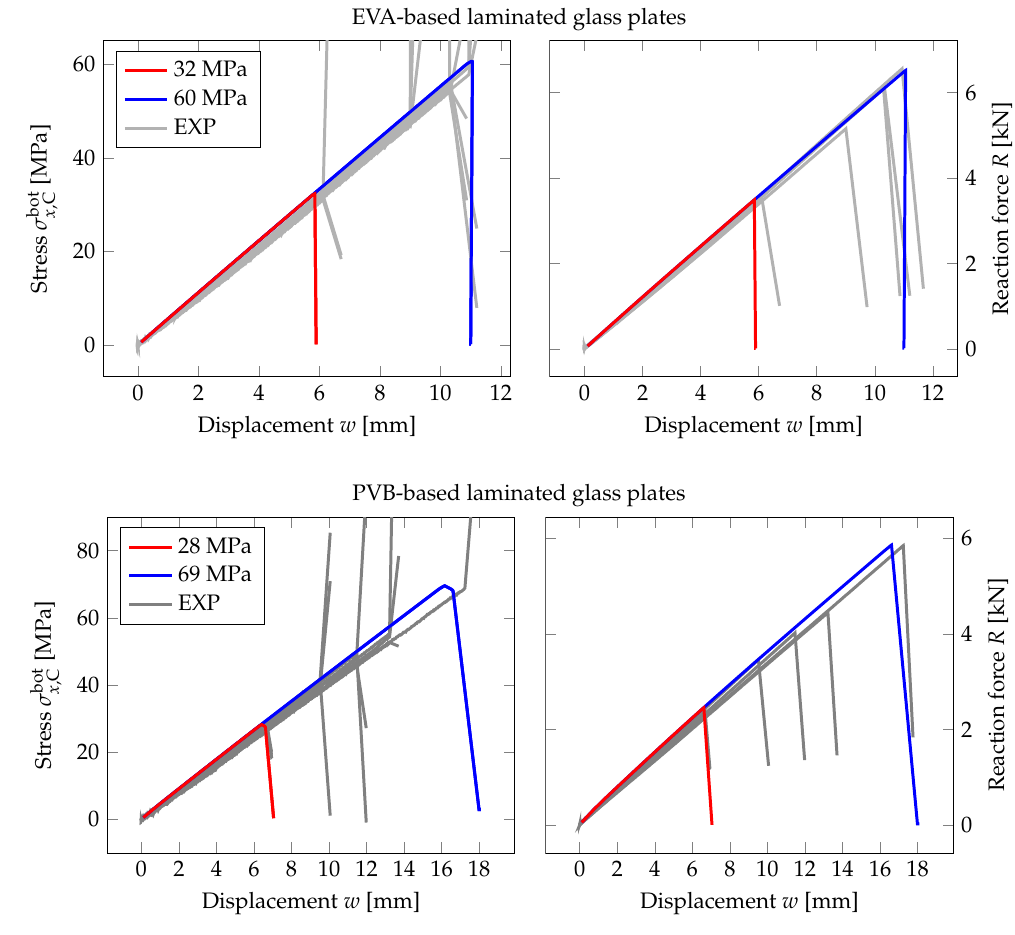
Figure 16. PF-P formulation, anisotropic staggered approach with the spectral-decomposition split, PS model: Evolution of the largest tensile stress at the midpoint and the overall reaction force under the loading points with respect to the midpoint deflection. Experimental data (EXP, grey lines); numerical response for the lowest measured failure stress (red) and for the highest value